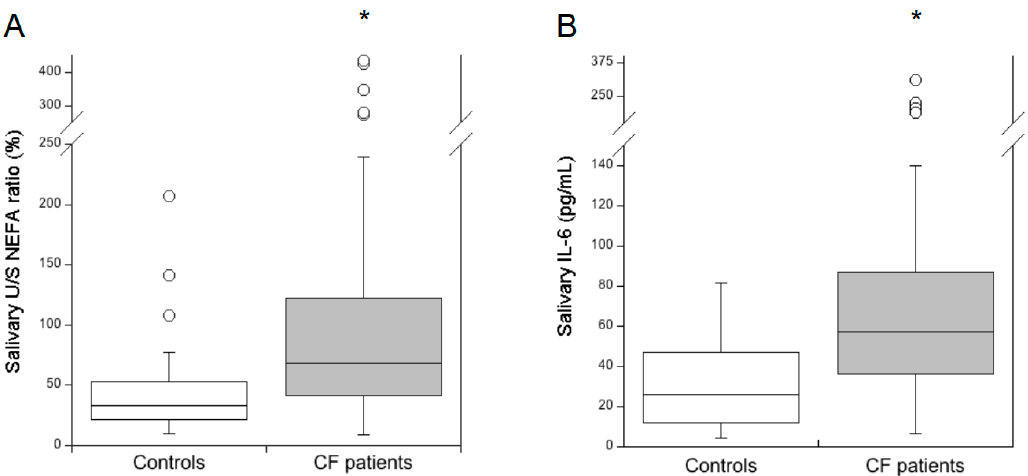
Figure 1. Comparison of the salivary unsaturated/saturated NEFA ratio (U/S NEFA ratio) ( A ) and interleukin 6 (IL-6) ( B ) between healthy subjects (controls, n = 48) and cystic fibrosis (CF) patients ( n = 66). * p < 1 × 10 -6 , Mann-Whitney U test. The U/S NEFA ratio was calculated by Equation (1).